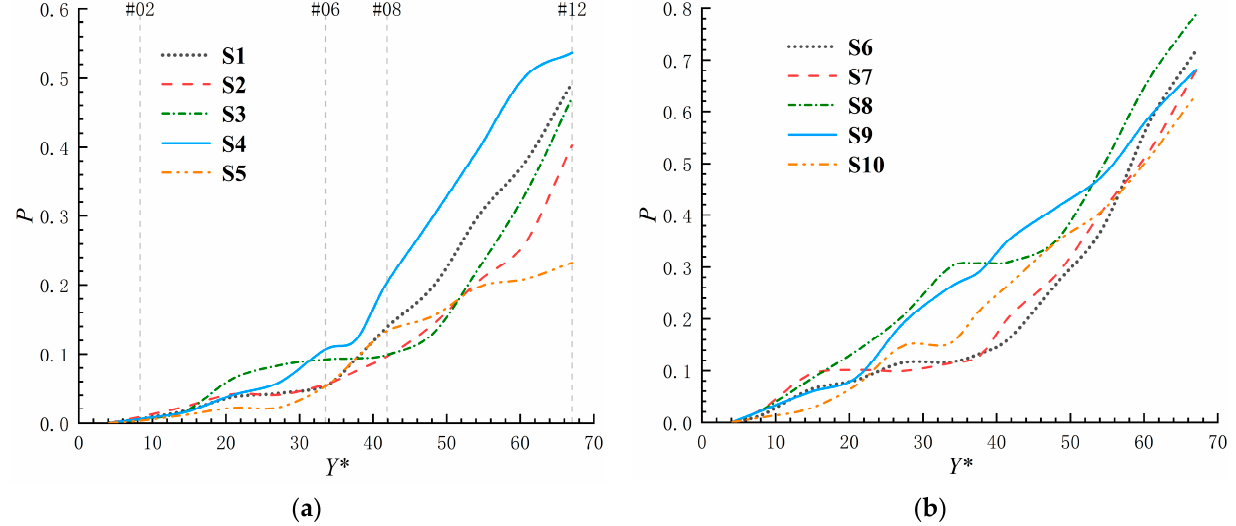
Figure 19. Percentage of complete mixing P in different scenarios along the channel. ( a ) Case S1– S5; ( b ) and Case S6–S10.